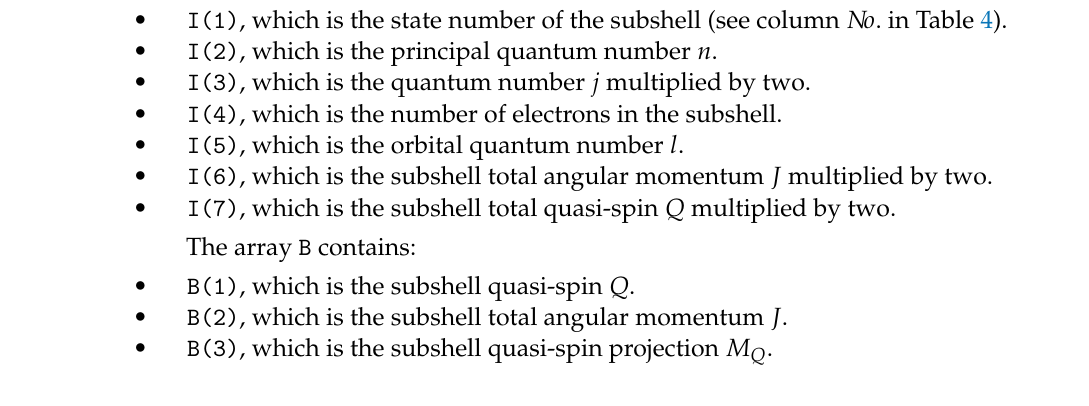
Table 4. Allowed couplings | ( n (cid:96) ) j w αν J (cid:105) of states for j = 1/2 − 9/2, which are in the array MT